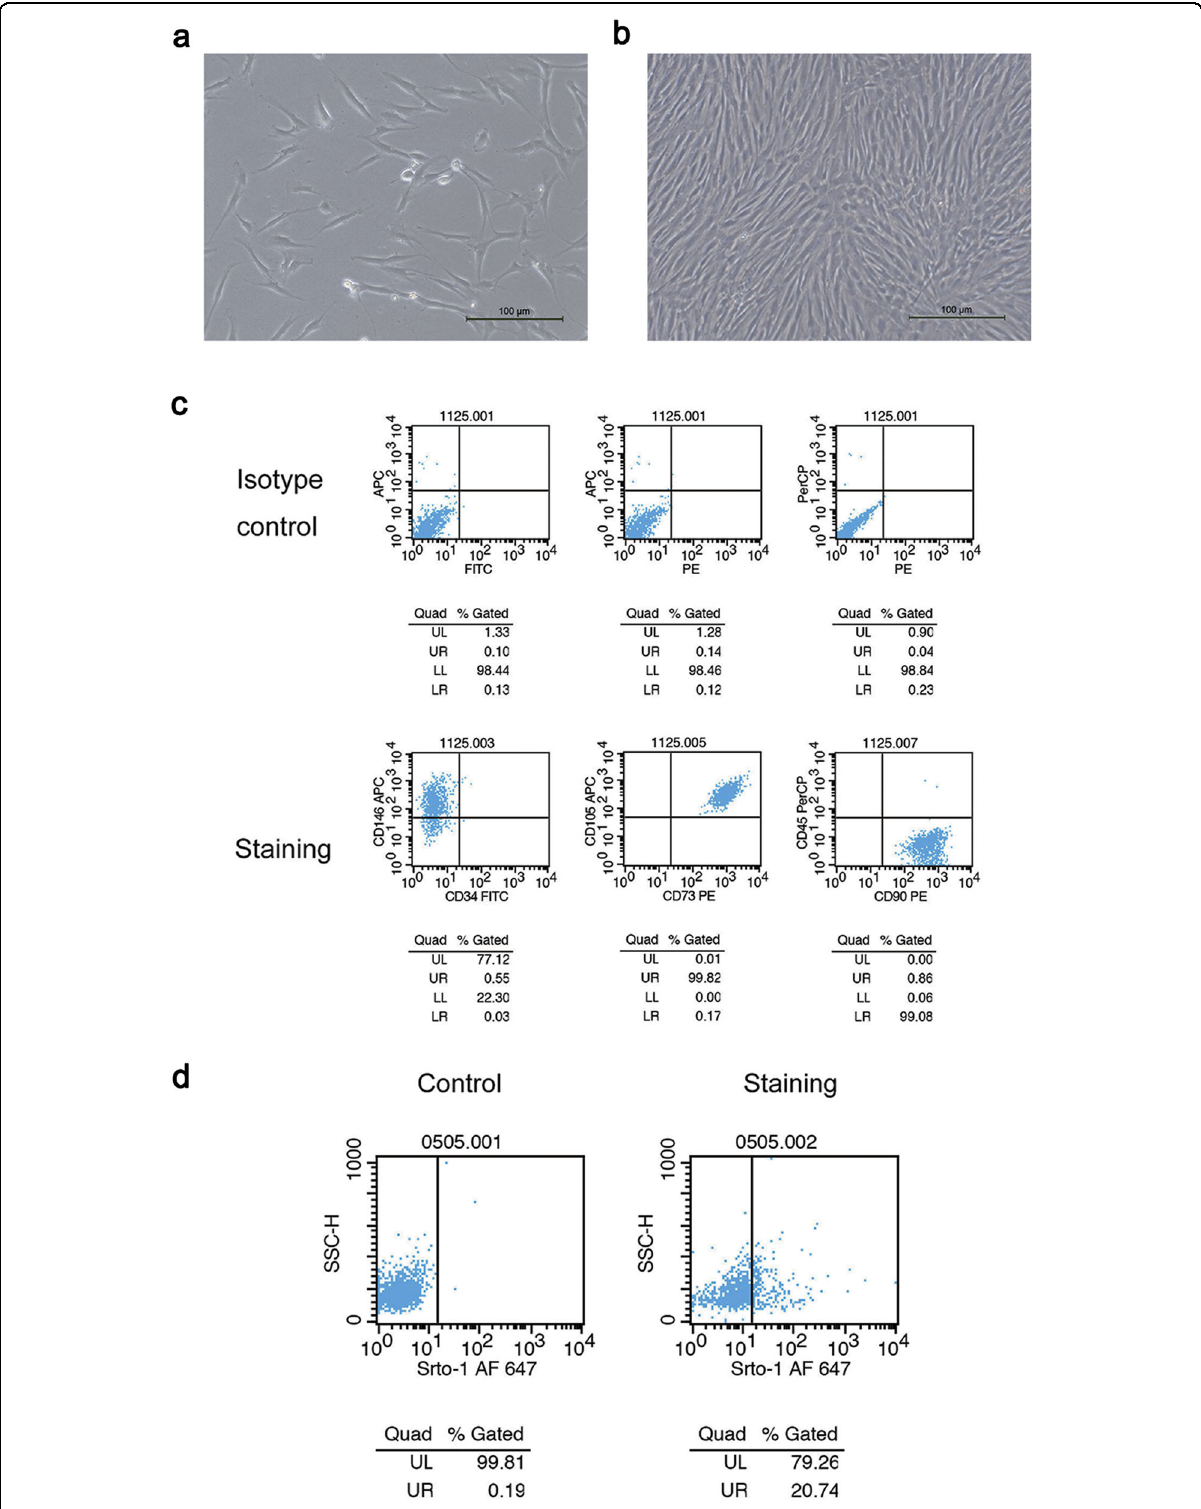
Fig. 1 Isolation and characterization of DPMSCs. a , b Isolated stem cells derived from human dental pulps displayed spindle-like and fi broblast- like morphology. c Flow cytometric analysis revealed that cultured DPMSCs were immunopositive for CD73 (99.99%), CD90 (99.94%), CD105 (99.83%), and CD146 (77.67%) but immunonegative for CD34 (0.58%) and CD45 (0.86%). Mouse IgG isotype control antibodies conjugated to FITC, PE, APC, or PerCP were used as negative controls. d Flow cytometry revealed that cultured DPMSCs were positive for STRO-1 (20.74%). PBS served as a negative control. Scale bars: 100 μ